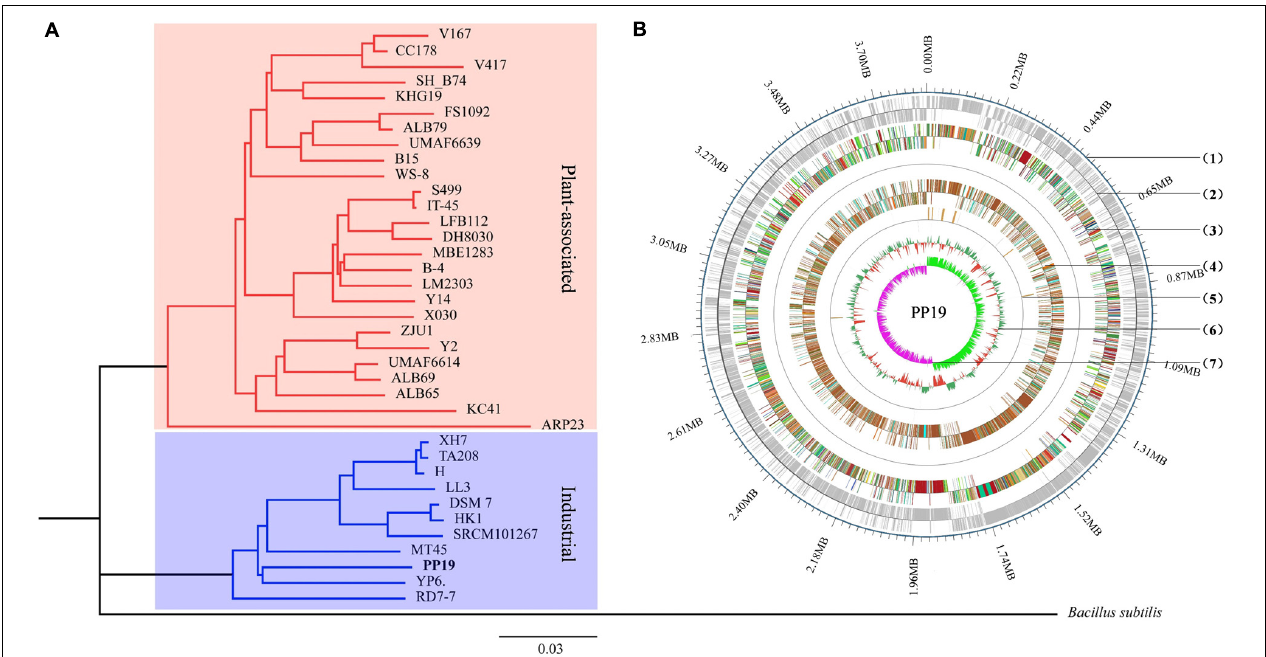
FIGURE 1 | Phylogenetic analysis and circular chromosome of strain PP19. (A) Phylogenetic tree of PP19 based on the whole genome sequences of 37 B. amyloliquefaciens strains with B acillus subtilis used as an outgroup. (B) The circular genome map revealing the genetic basis of PP19. From outside to inside, the map shows the (1) position of the genome, (2) coding genes on the + and – strand, (3) COG annotation, (4) GO annotation, (5) non-coding RNA, and (6) GC content. The inner red indicates that the GC content in this region is lower than the genome-wide average GC content, while the outer green indicates the opposite. The higher the peak is, the greater the difference with the average GC content (7) GC skew value (G–C/G + C). When the value is positive, the CDS is more likely to be transcribed from the positive chain; otherwise, the CDS is more likely to be transcribed from the negative